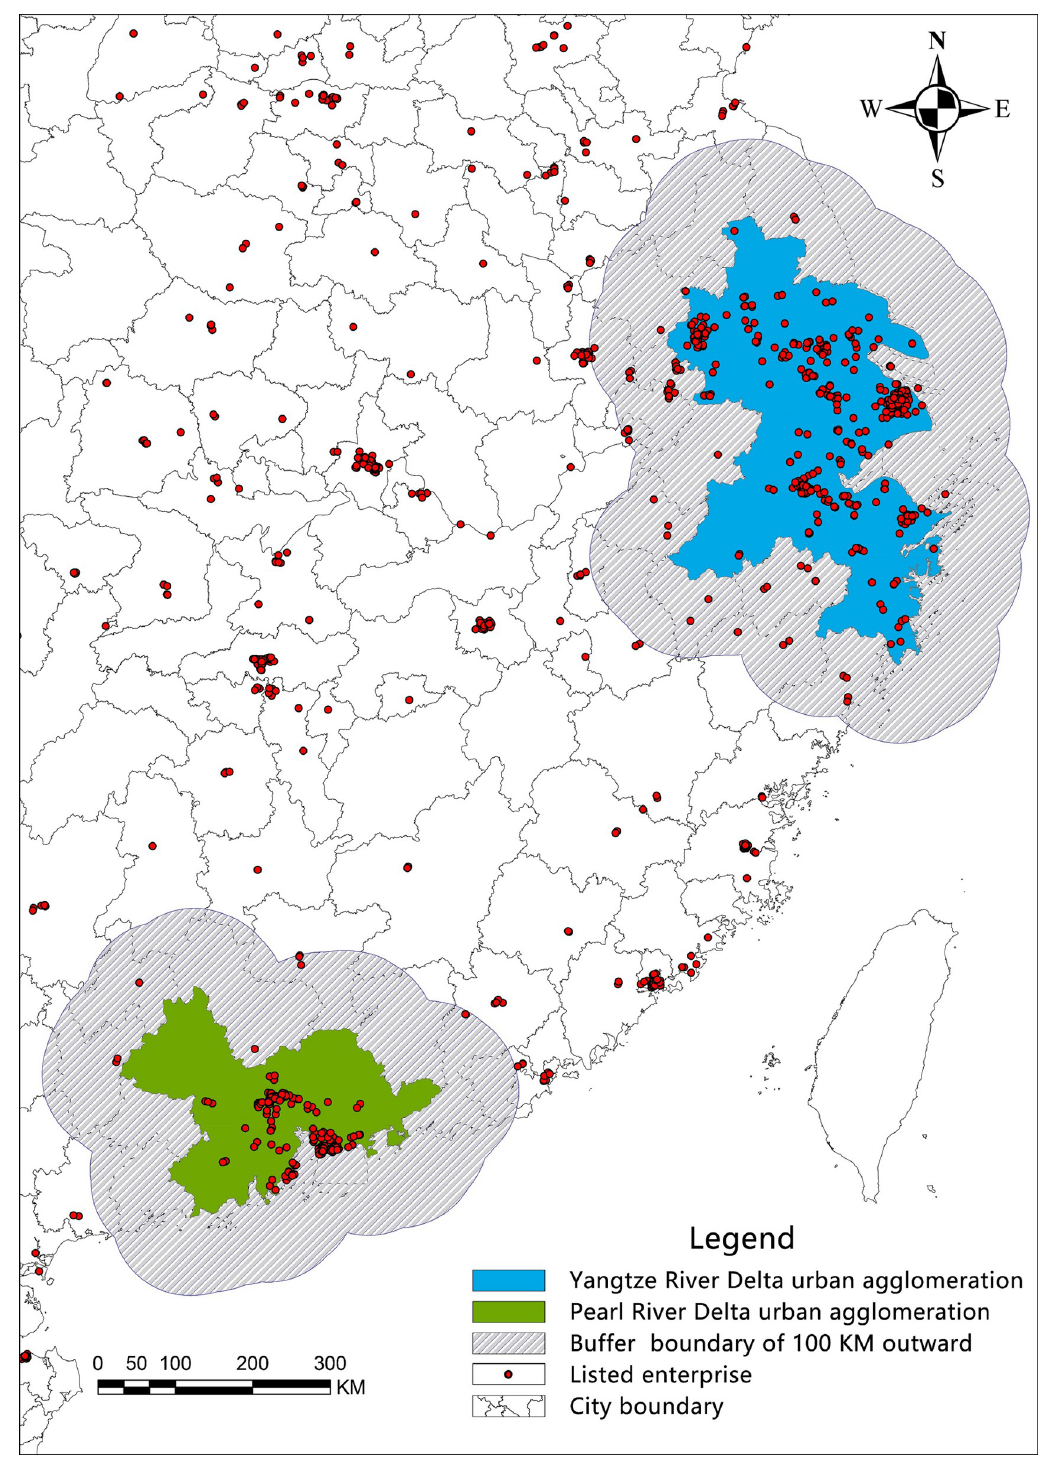
Fig 2. Boundary and buffer of urban